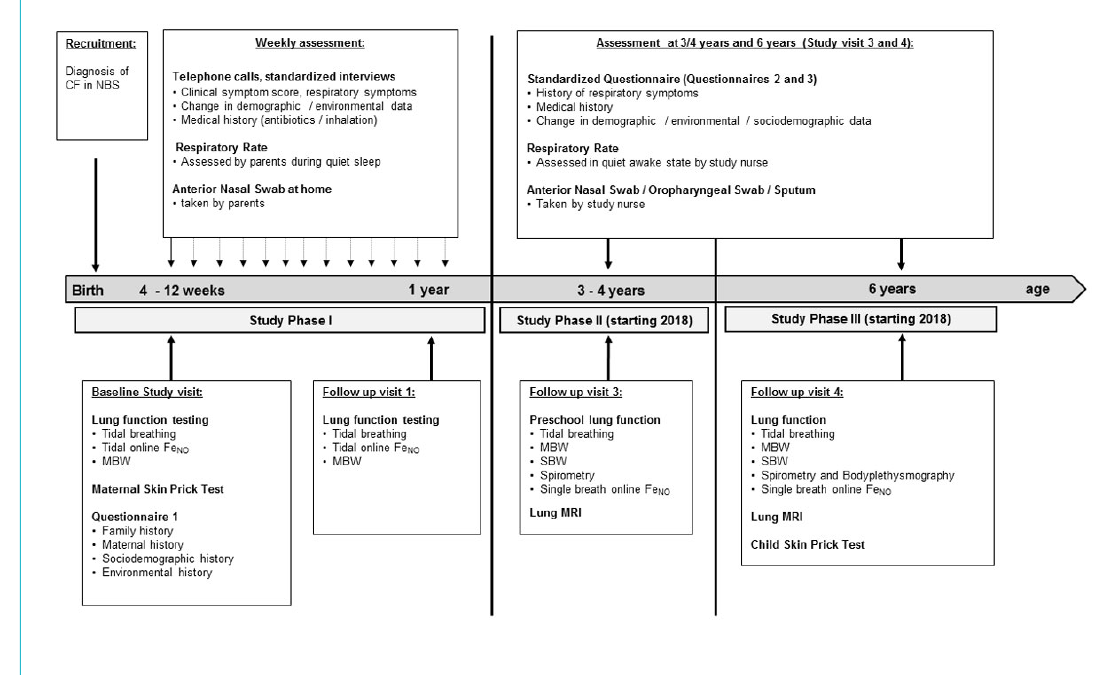
Figure 1: Design of the SCILD cohort study – flow chart of data collection.NBS = new-born screening; Fe NO = exhaled nitric oxide; MBW = multiple breath washout, SBW = single breath washout; MRI = magnet resonance